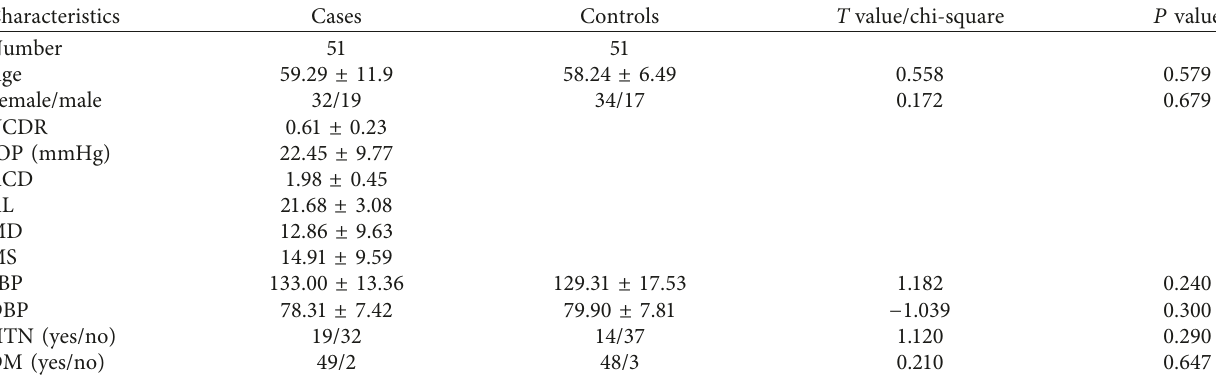
Table 1: Demographics and clinical characteristics of subjects.